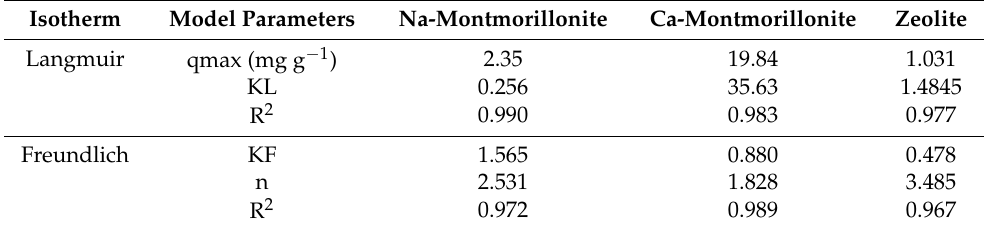
Figure 4. Adsorption isotherm for ( a ) Na-montmorillonite, ( b ) Ca-montmorillonite, and ( c ) Zeolite; (1) Experimental data, (2) the Freundlich adsorption isotherms, and (3) the Langmuir adsorption isotherms. qe: number of milligrams of adsorbate that is adsorbed per gram of adsorbent; Ce: concentration of adsorbate in solution when equilibrium has been reached. Table 7. Langmuir and Freundlich isotherm models parameters for